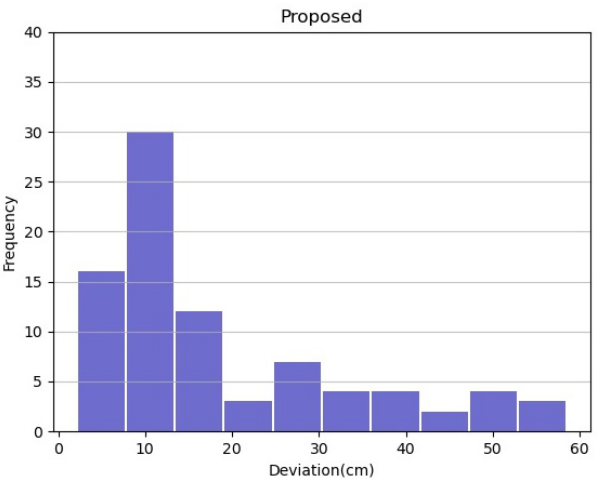
Figure 9. Histogram of deviation between center vehicle and median lane using only GPS.